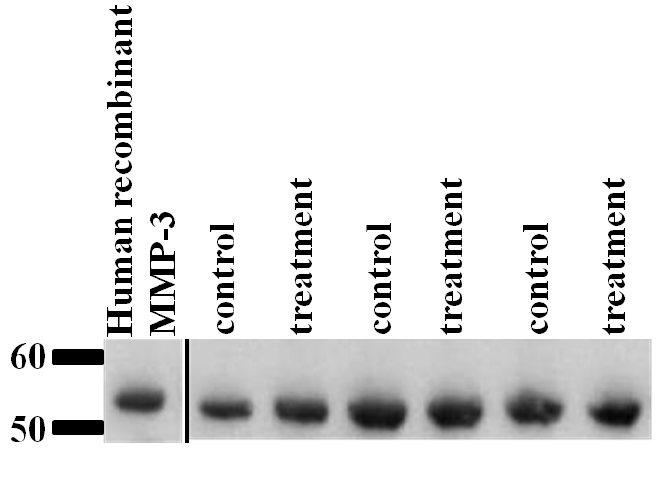
Figure 3. Cartilage explants treated with Il-1β did not demonstrate altered MMP-3 protein expression. Western blot analysis using antibodies to MMP-3 on cartilage explant supernatant cultured with and without IL-1β. Images of western blots for control and IL-1β treated (treatment) cartilage explants. Volumes of supernatant loaded were normalised to dry weight of cartilage. Human recombinant MMP-3 was used as a positive control. There was no difference in the relative intensity the bands following analysis in ImageJ (data not